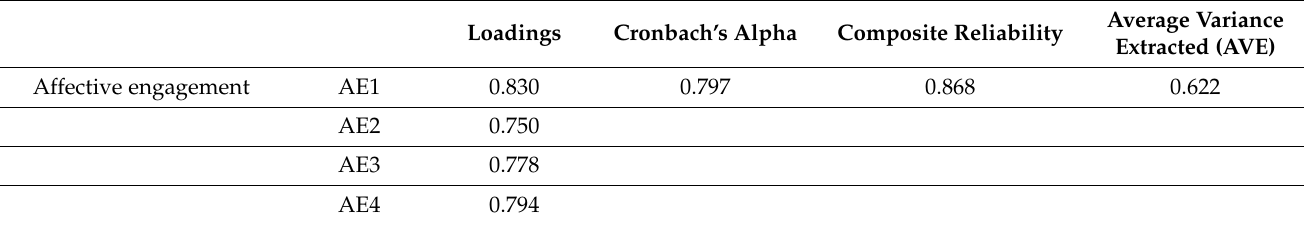
Table 3. Factor loading, reliability, and